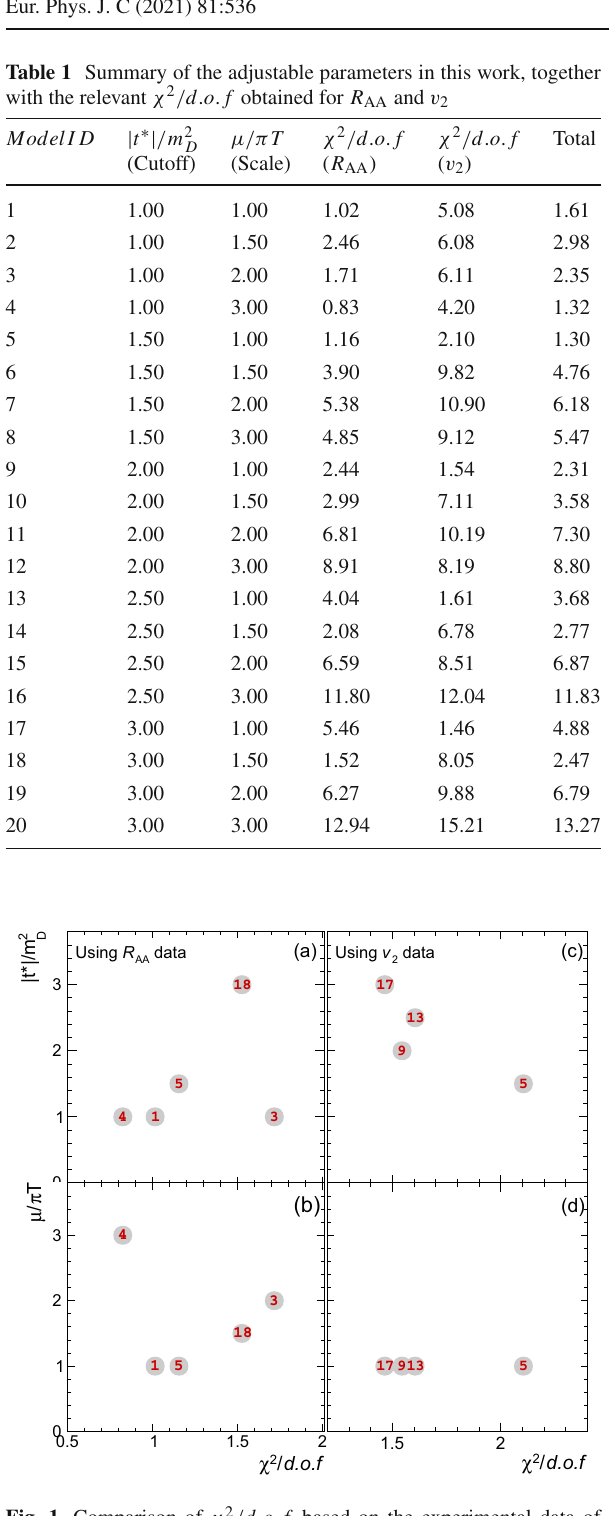
Fig. 1 Comparison of χ 2 / d . o . f based on the experimental data of R AA (left) and v 2 (right). The model predictions are calculated by using various combinations of parameter | t ∗ | / m 2 (upper) and μ/π T (lower), D which are represented as χ 2 / d . o . f (x-axis) and the desired parameter (y-axis), respectively. See the legend and text for